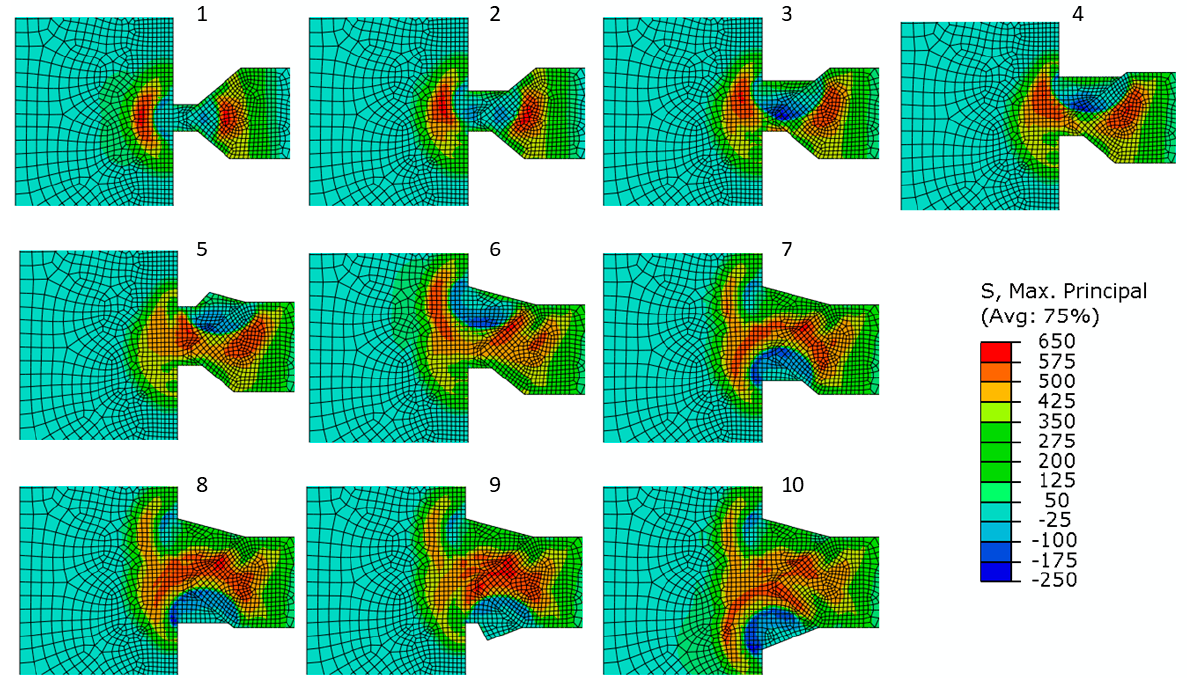
Figure 7. Residual stress development in the FE model with Ms = 400 ◦ C. Figure 7 . Residual stress development in the FE model with Ms = 400 °C.